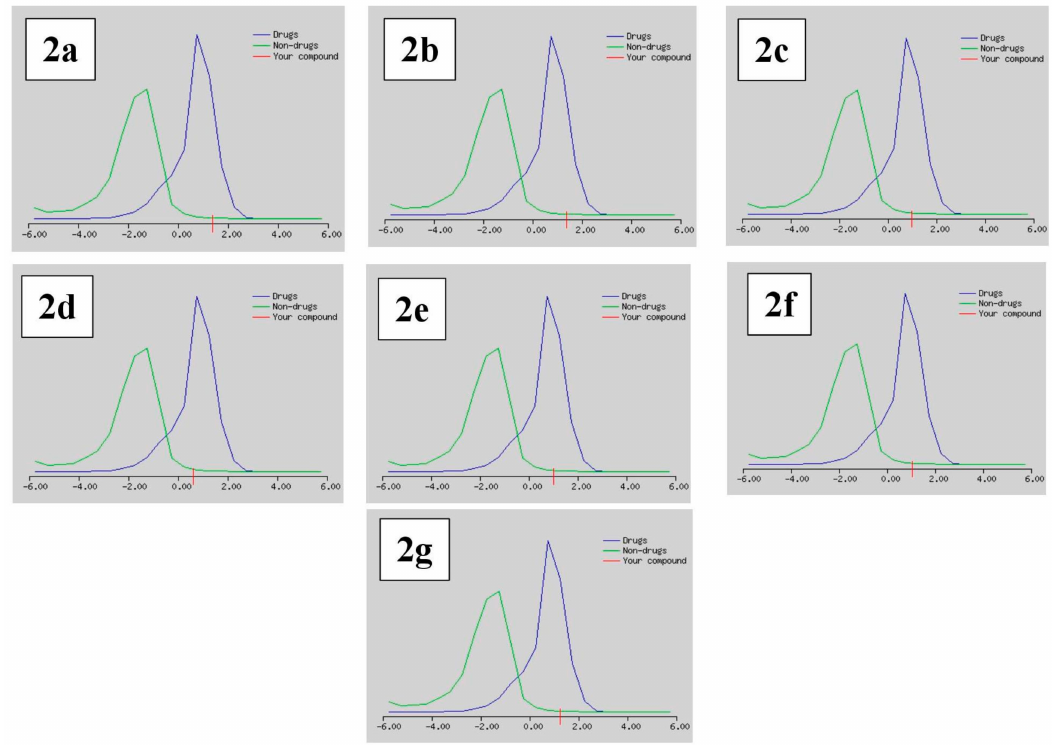
Figure 5. Drug likeness score model of the selected compounds 2a – 2g